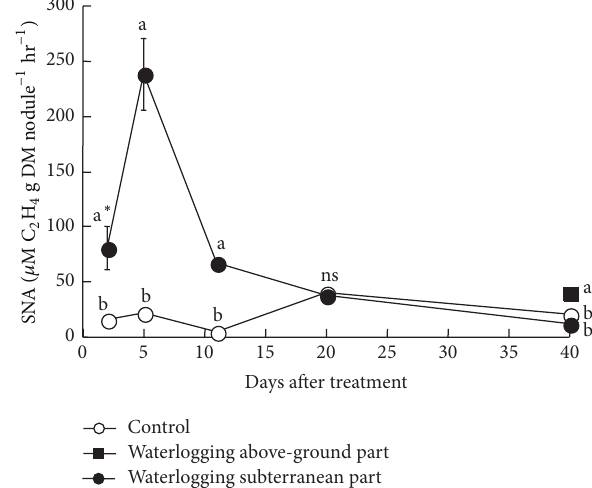
Figure 9: Changes in specific nitrogenase activity (SNA) in experiment 2. ∗ Symbols with different letters at each sampling day are significantly different at 𝑃 < 0.05 ; ns: not significant. Error bars give ± one SE ( 𝑛 = 3